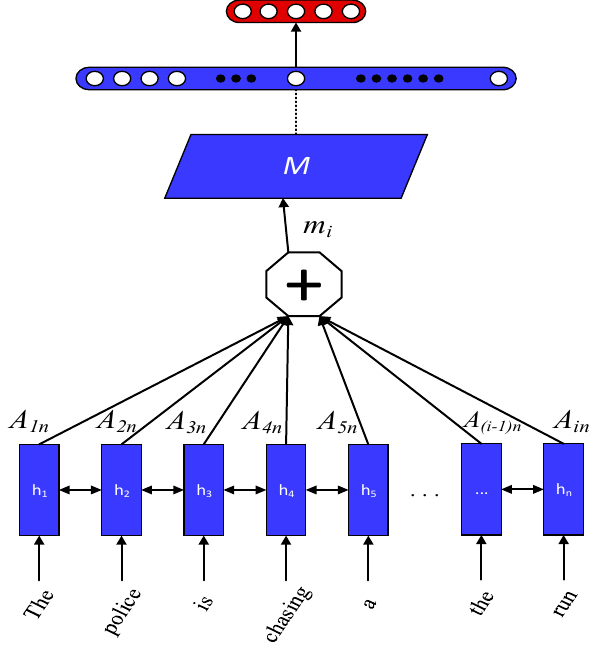
Figure 3. The structure and functionality of a self-attention mechanism.